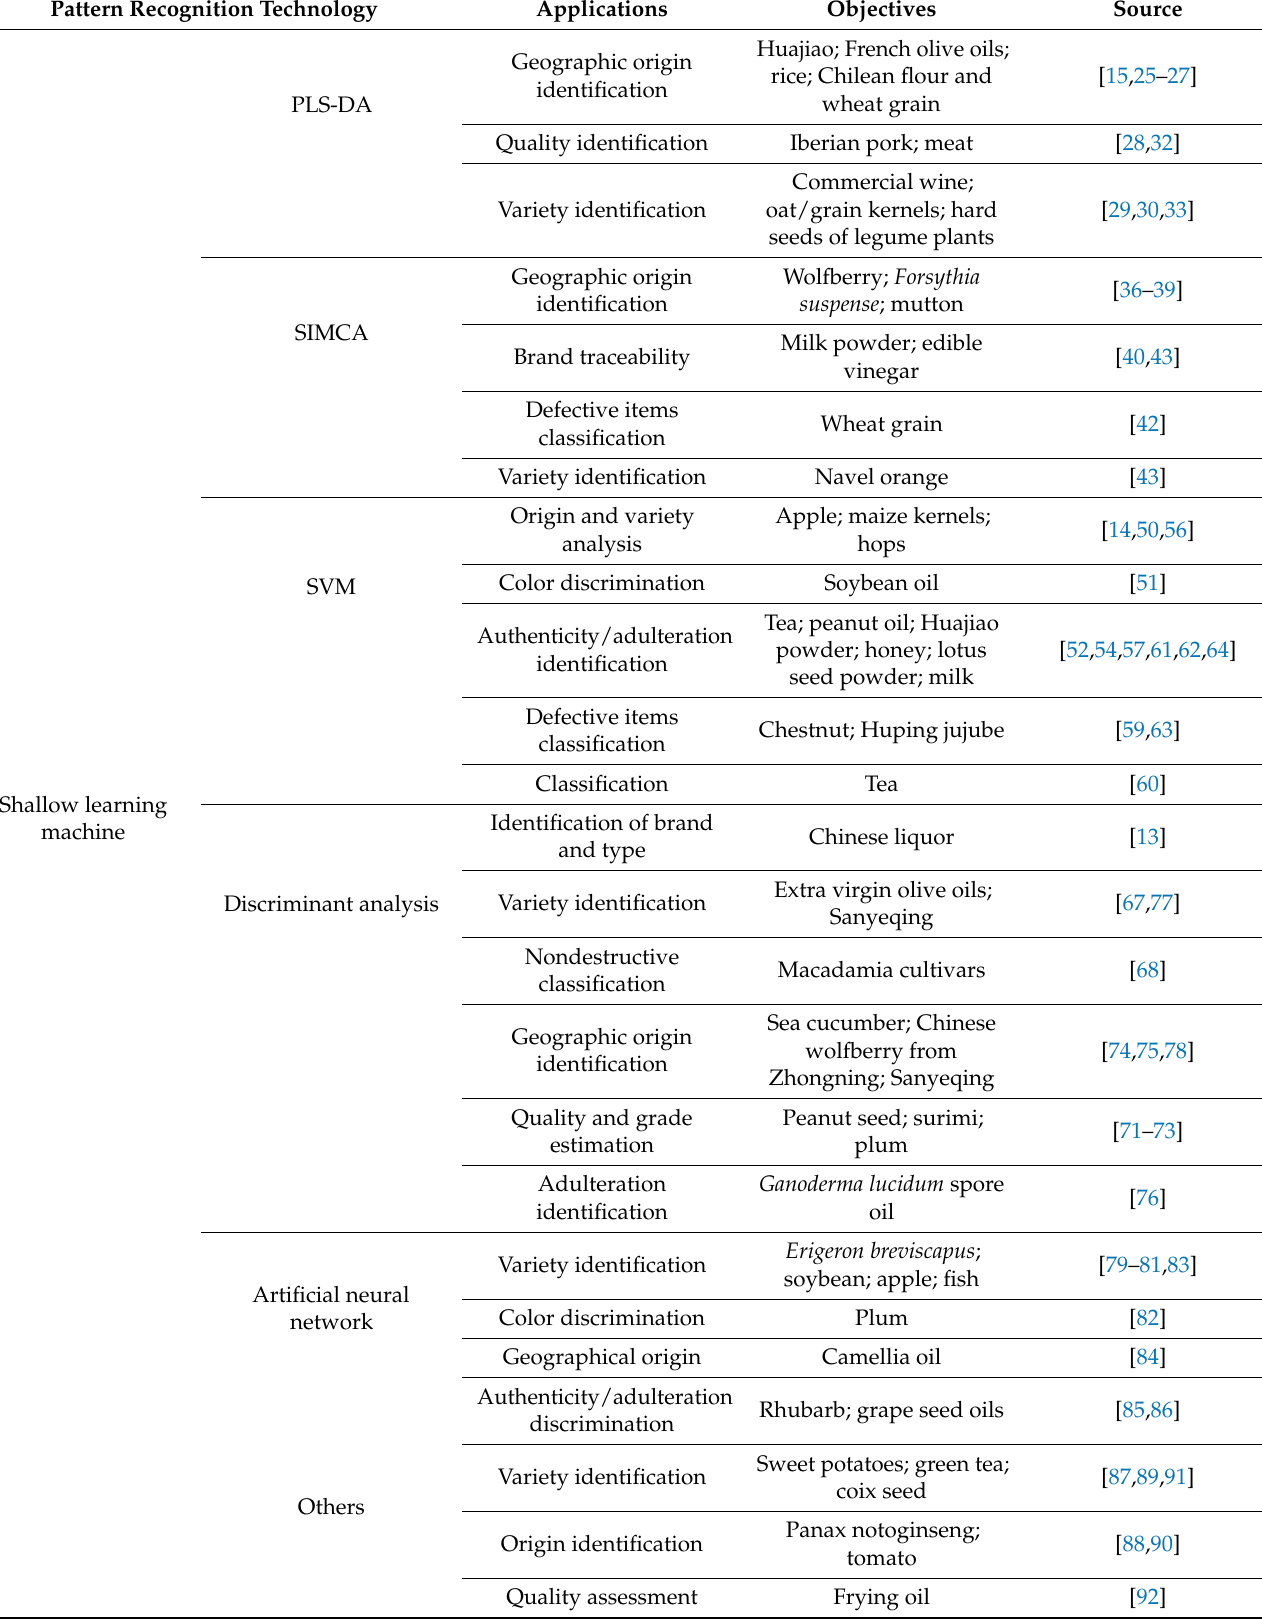
Table 2. Application of pattern recognition technology for the qualitative analysis of